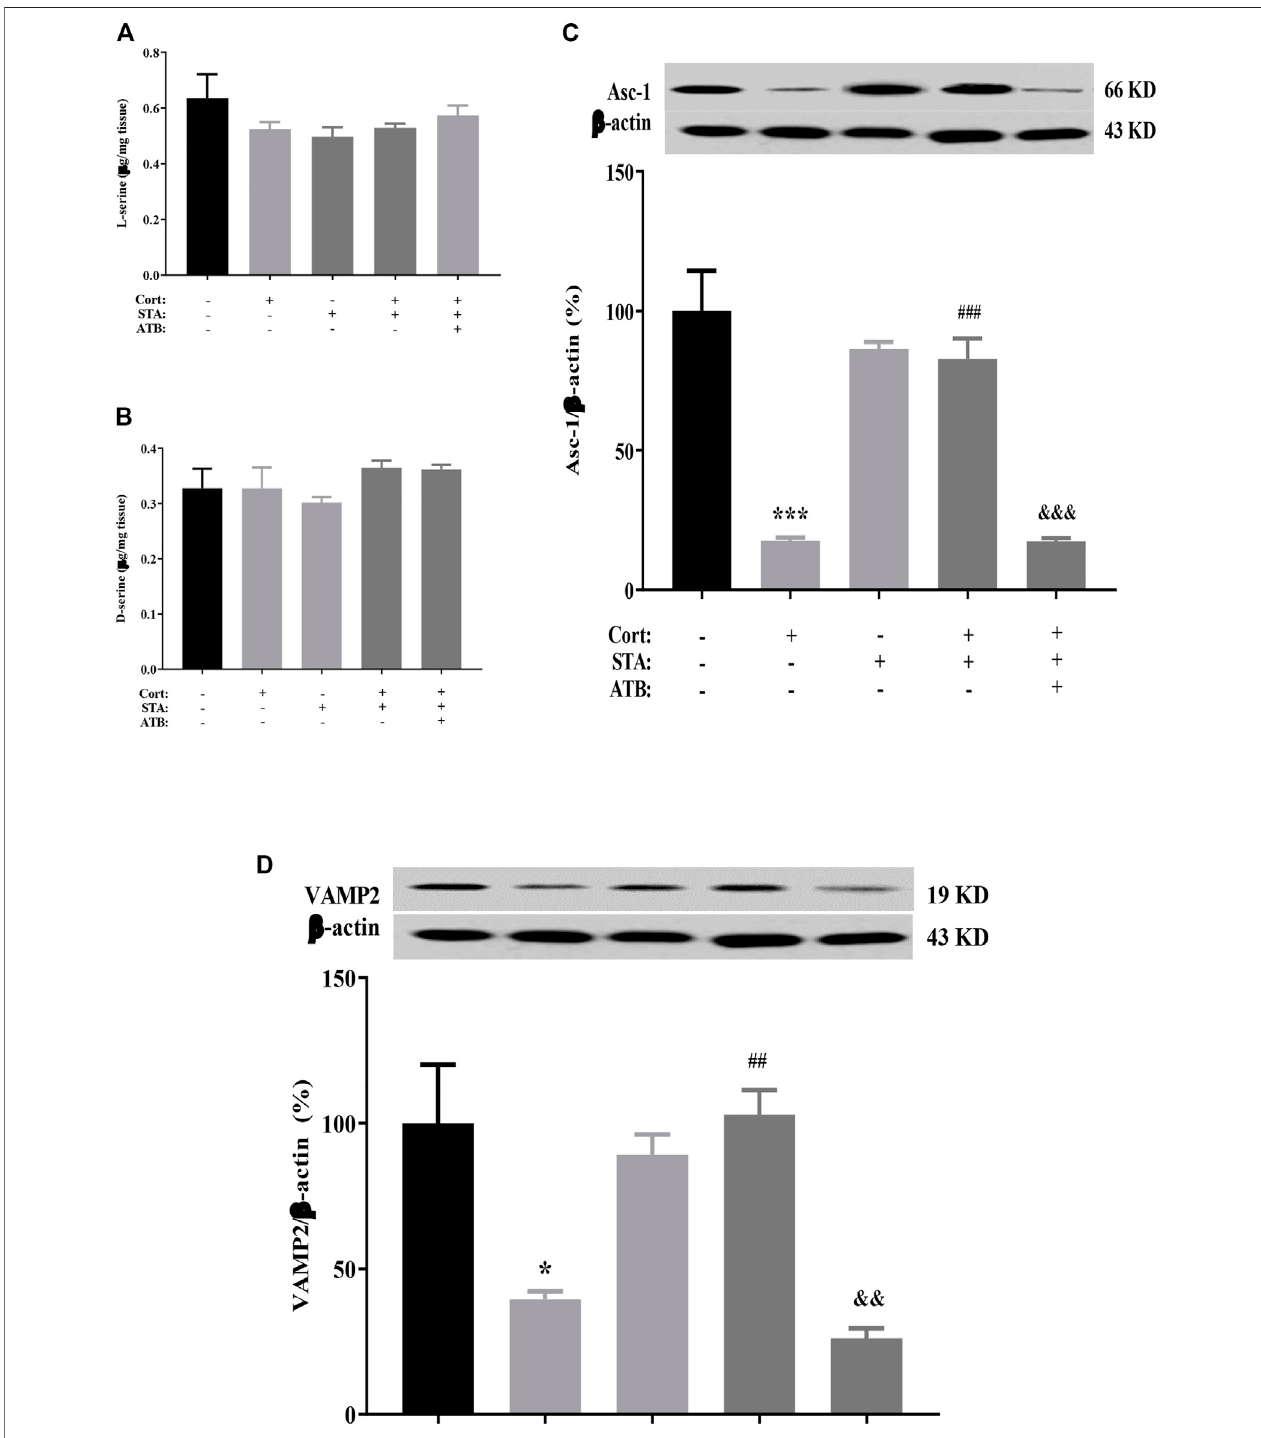
FIGURE 3 | Effects of stachyose (STA) on the D -serine metabolic pathway. (A) Effects of STA on the level of L -serine in the hippocampus. (B) Effects of STA on the levelofD-serineinthehippocampus. (C) EffectsofSTAontheproteinexpressionlevelofASC-1inthehippocampus. (D) EffectsofSTAontheproteinexpressionlevelof VAMP2 in the hippocampus. Data are shown as the mean ± SEM, n = 4. * p < 0.05, *** p < 0.001 compared to the Control group; ## p < 0.01, ### p < 0.001 compared to the Cort group; && p < 0.01, &&& p < 0.001 compared to the STA + Cort group. ASC-1, Na + -independent alanine – serine – cysteine transporter-1; VAMP2, vesicle- associated membrane protein